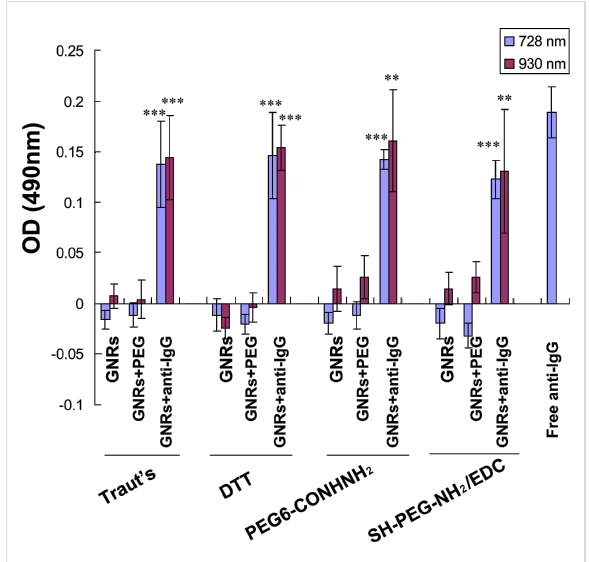
Figure 3: The biological functionality of anti-IgG from the four thiola- tion methods for immobilization on GNR surfaces by ELISA tests. Data are expressed as mean ± SD from three independent tests performed in triplicates (** P < 0.01; *** P < 0.001, compared with the GNRs and